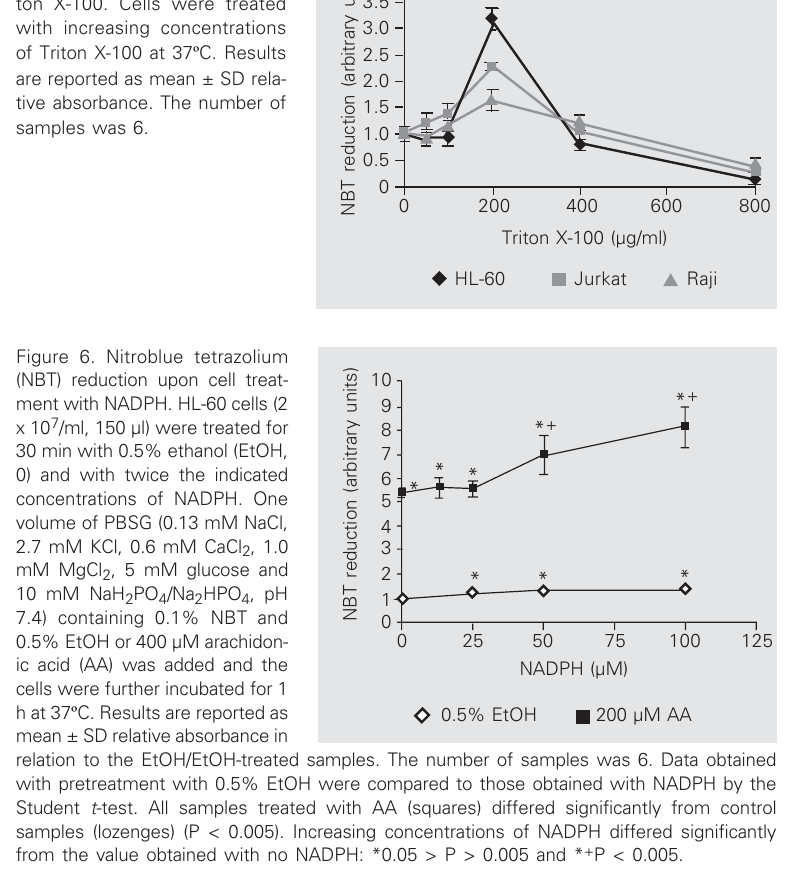
Figure 5. Nitroblue tetrazolium (NBT) reduction induced by Tri- ton X-100. Cells were treated with increasing concentrations of Triton X-100 at 37 º C. Results are reported as mean ± SD rela- tive absorbance. The number of samples was 6.